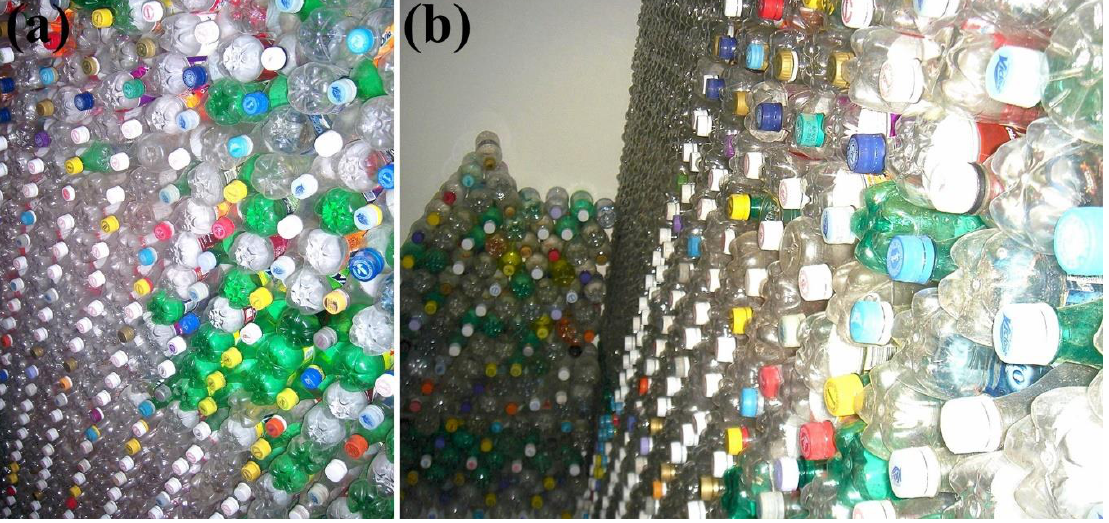
Figure 1. (a) – (b ) Two different views of the collected polyethylene terephthalate (PET) bottles, under Figure 1. ( a , b ) Two di ff erent views of the collected polyethylene terephthalate (PET) bottles, under storage, before building the prototype. storage, before building the